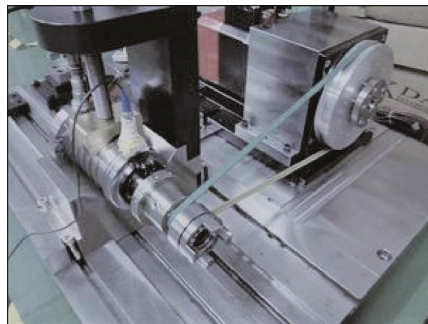
Figure 7: Experimental platform.